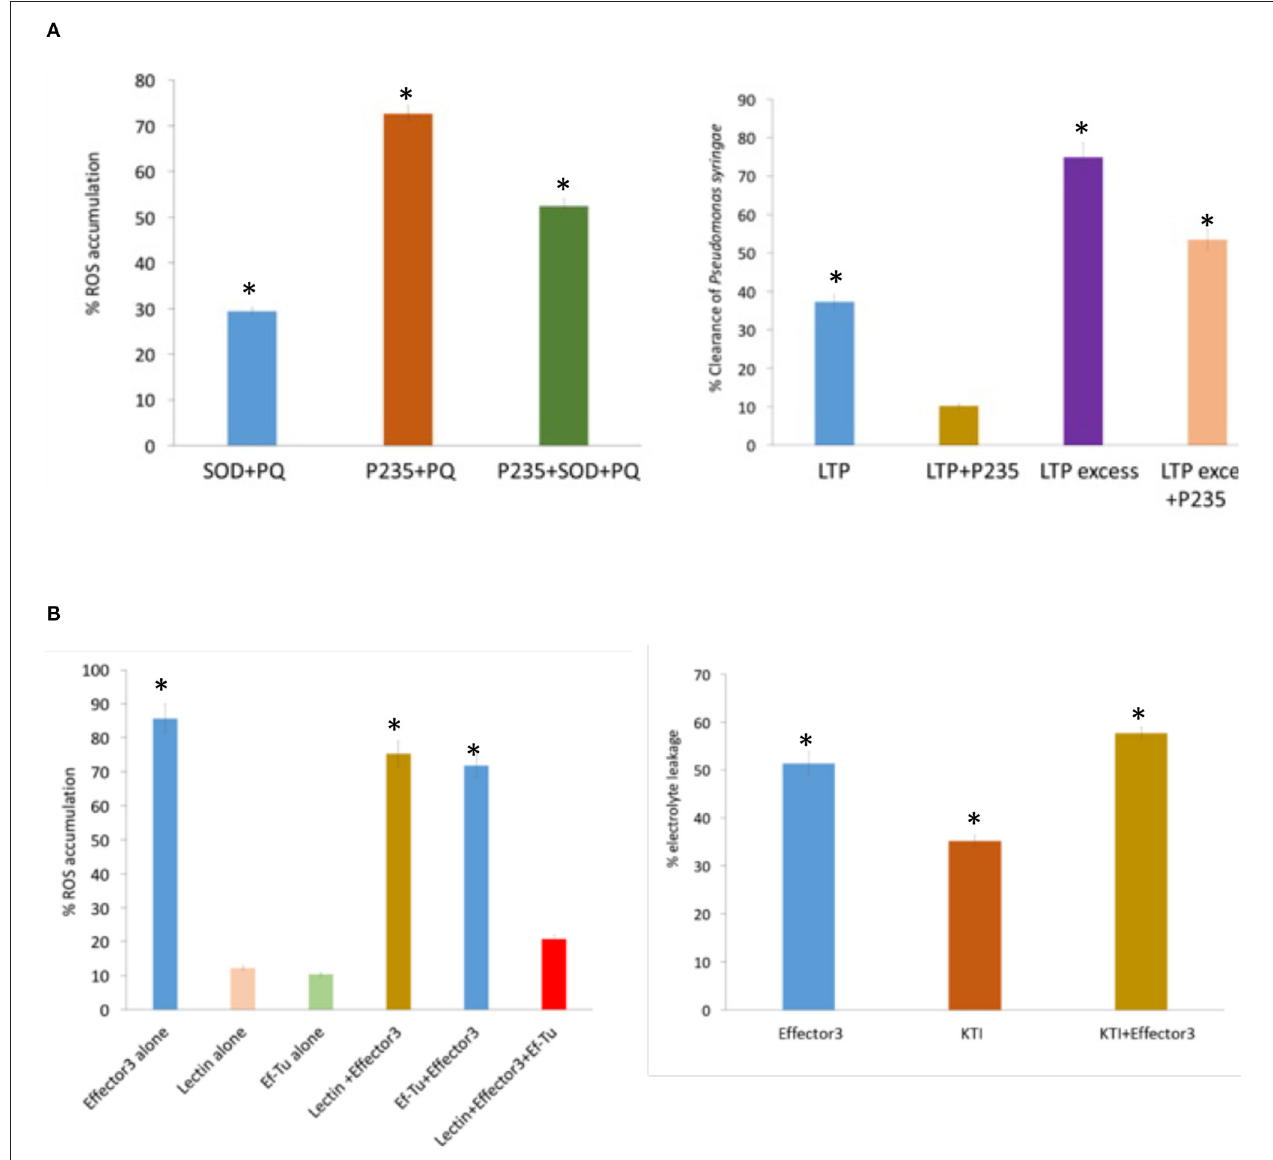
FIGURE 3 | In vitro and in planta assays to demonstrate the inhibitory activity of the C Las effectors on their citrus protein targets. First, enzymatic, binding, or bactericidal assays are performed to determine the appropriate functional properties of the citrus target proteins and subsequently, the same assays are conducted to demonstrate the inhibitory activities of the C Las effectors on their citrus targets. [ (A) , left] The inhibitory effect of LasP 235 on SOD is monitored in tobacco by fluorescence microscopy. [ (A) , right] Percentage reduction relative to the initial CFU of E. coli ATCC25922 by LTP alone and LTP plus LasP 235 . [ (B) , left] The ability of Effector 3 to induce the ROS release in tobacco. The addition of lectin or Ef–Tu is not sufficient to suppress the ROS release by Effector 3. However, the combination of lectin and Ef–Tu significantly reduces the ROS release by Effector 3. [ (B) , right] The electrolyte leakage due to ROS-produced by PQ is set 100%. A relative electrolyte leakage due to infiltration of Effector 3, KTI, and Effector 3 + KTI in tobacco. *Indicates statistical significance at p ≤